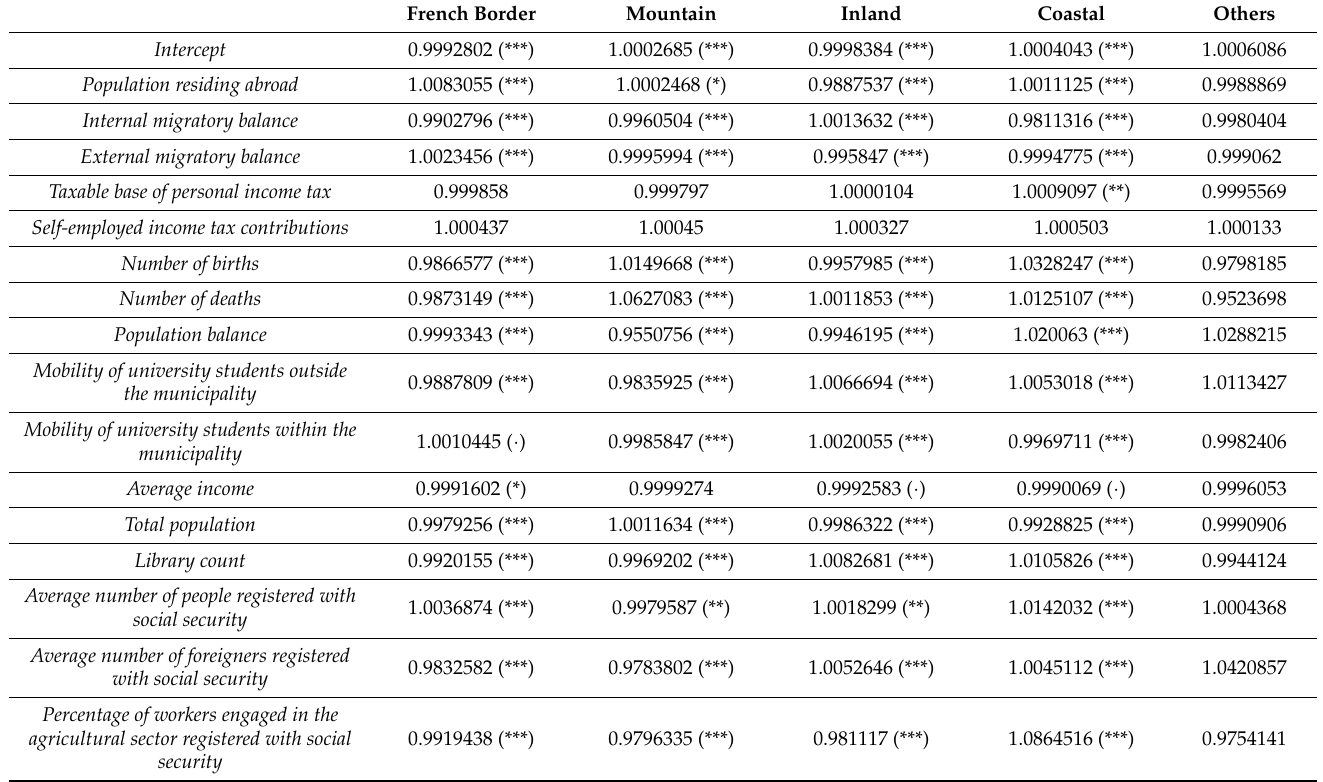
Table 6. Probability of a municipality belonging to each of the clusters (odds